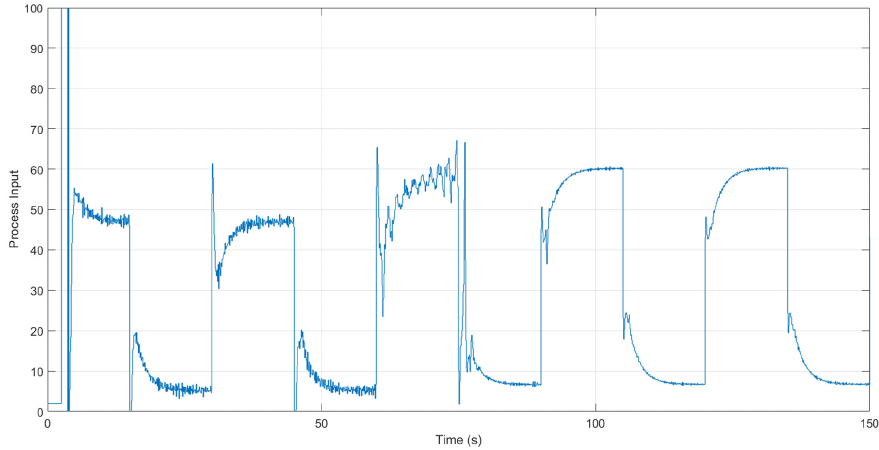
Figure 6. Applied controls (process input) in the unconstrained case. Electronics 2017 , 6 , 88